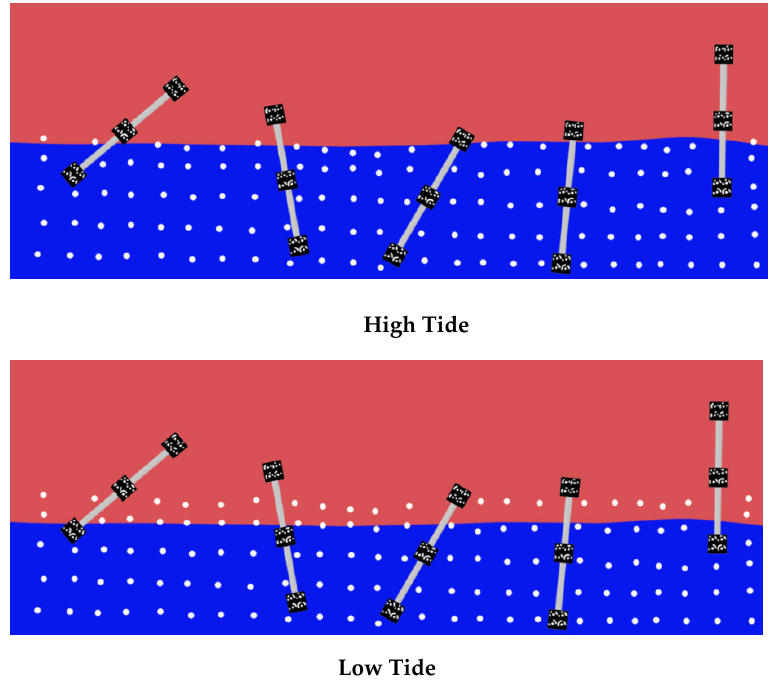
Figure 6. Rods and scale bars on the Costa Concordia hull. As explained in the tests, 5 linking targets (named orientation devices OD, e ) were positioned on the shipwreck with a minimum of one plate and a maximum of two plates both above the water ( a, b ) and underwater ( c d ). Scale bars (SB) were also attached both above the water and underwater ( e ).